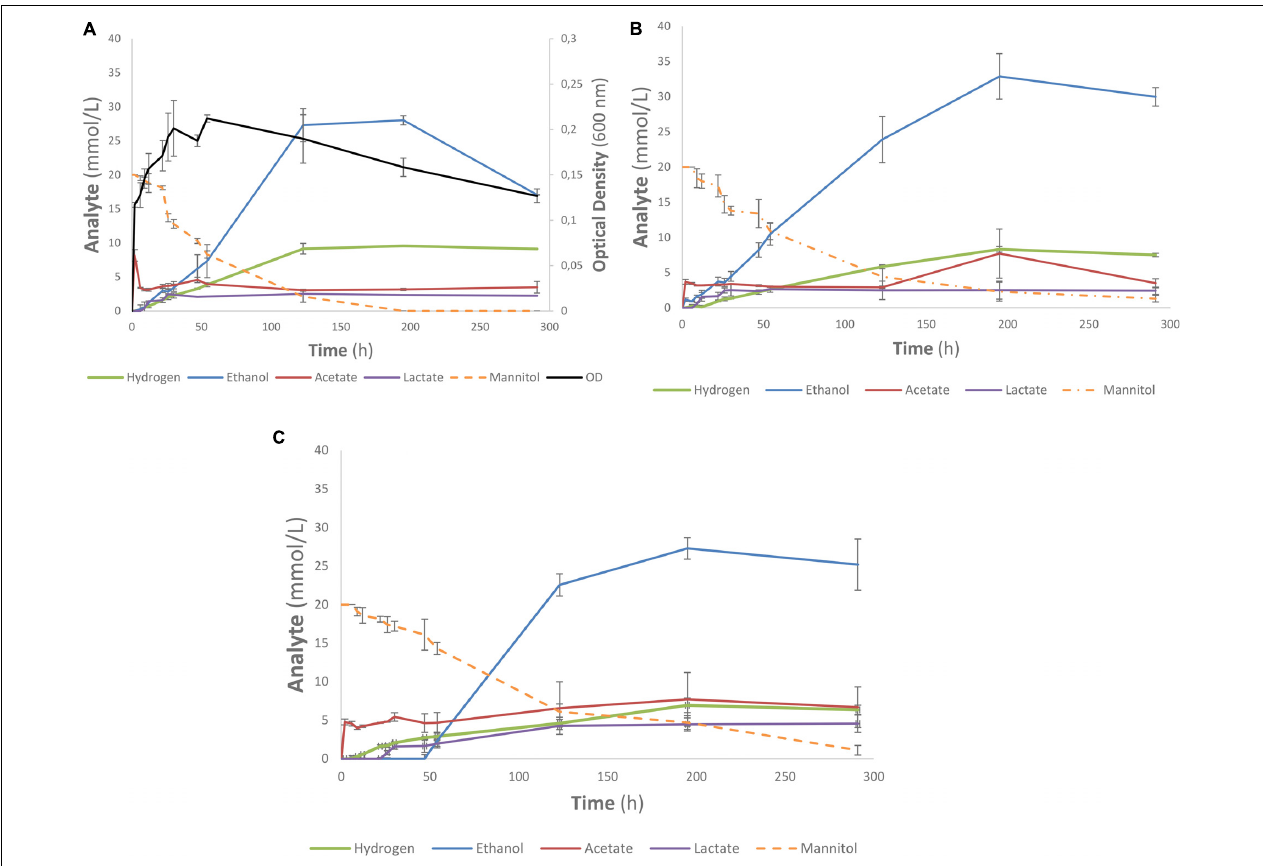
FIGURE 5 | Profile of mannitol-containing media using Thermoanaerobacter pseudoethanolicus (DSM 2355). (A) 20 mM mannitol, (B) Ascophyllum nodosum extracted diluted to 20 mM mannitol, (C) Laminaria digitata extract diluted to 20 mM mannitol. Data points represent the average values of triplicates with SD presented as error bars.